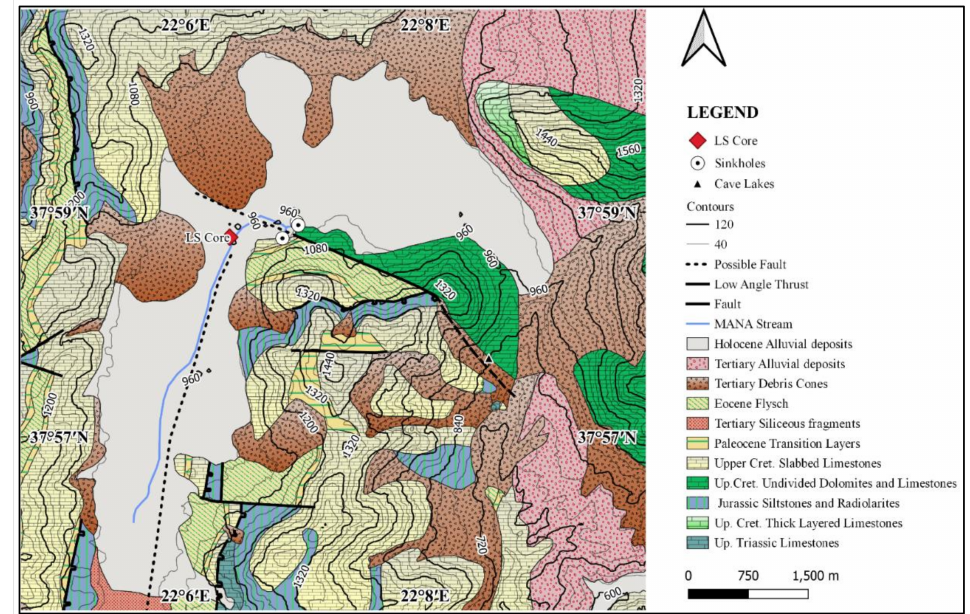
Figure 3. Geological map of the study area according to